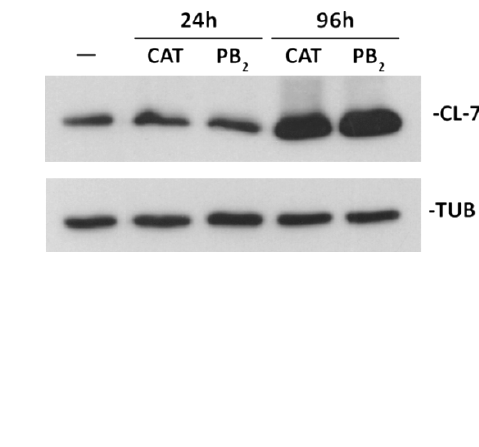
Figure 1. Trans-epithelial electrical resistance of Caco-2/HT29-MTX monolayers. Effect of macrophage-conditioned medium. After a tight monolayer had formed, (+)-catechin (CAT) and procyanidin B 2 (PB 2 ) (50 µM) were added, where indicated, to the apical chamber (T0). After 24 h, the medium in the basolateral chamber was replaced by conditioned medium of Raw264.7 macrophages stimulated by LPS (conditioned medium of activated macrophages (MCM), see Methods) and the incubation prolonged for further 72 h. Trans-epithelial electrical resistance (TEER) was determined, as described under Methods, at the indicated times and expressed as changes relative to control cells, calculated according to Equation 1 (see Methods). Control cells were monolayers treated with conditioned medium obtained from Raw264.7 cultures not activated by LPS (see Methods). Data are means ± SD of 3 independent determinations. *** p < 0.001 vs. control cultures; #, ##, ### p < 0.05, 0.01, 0.001 vs. monolayers treated with CAT and PB 2 but not with MCM. The experiment was performed twice with comparable results.